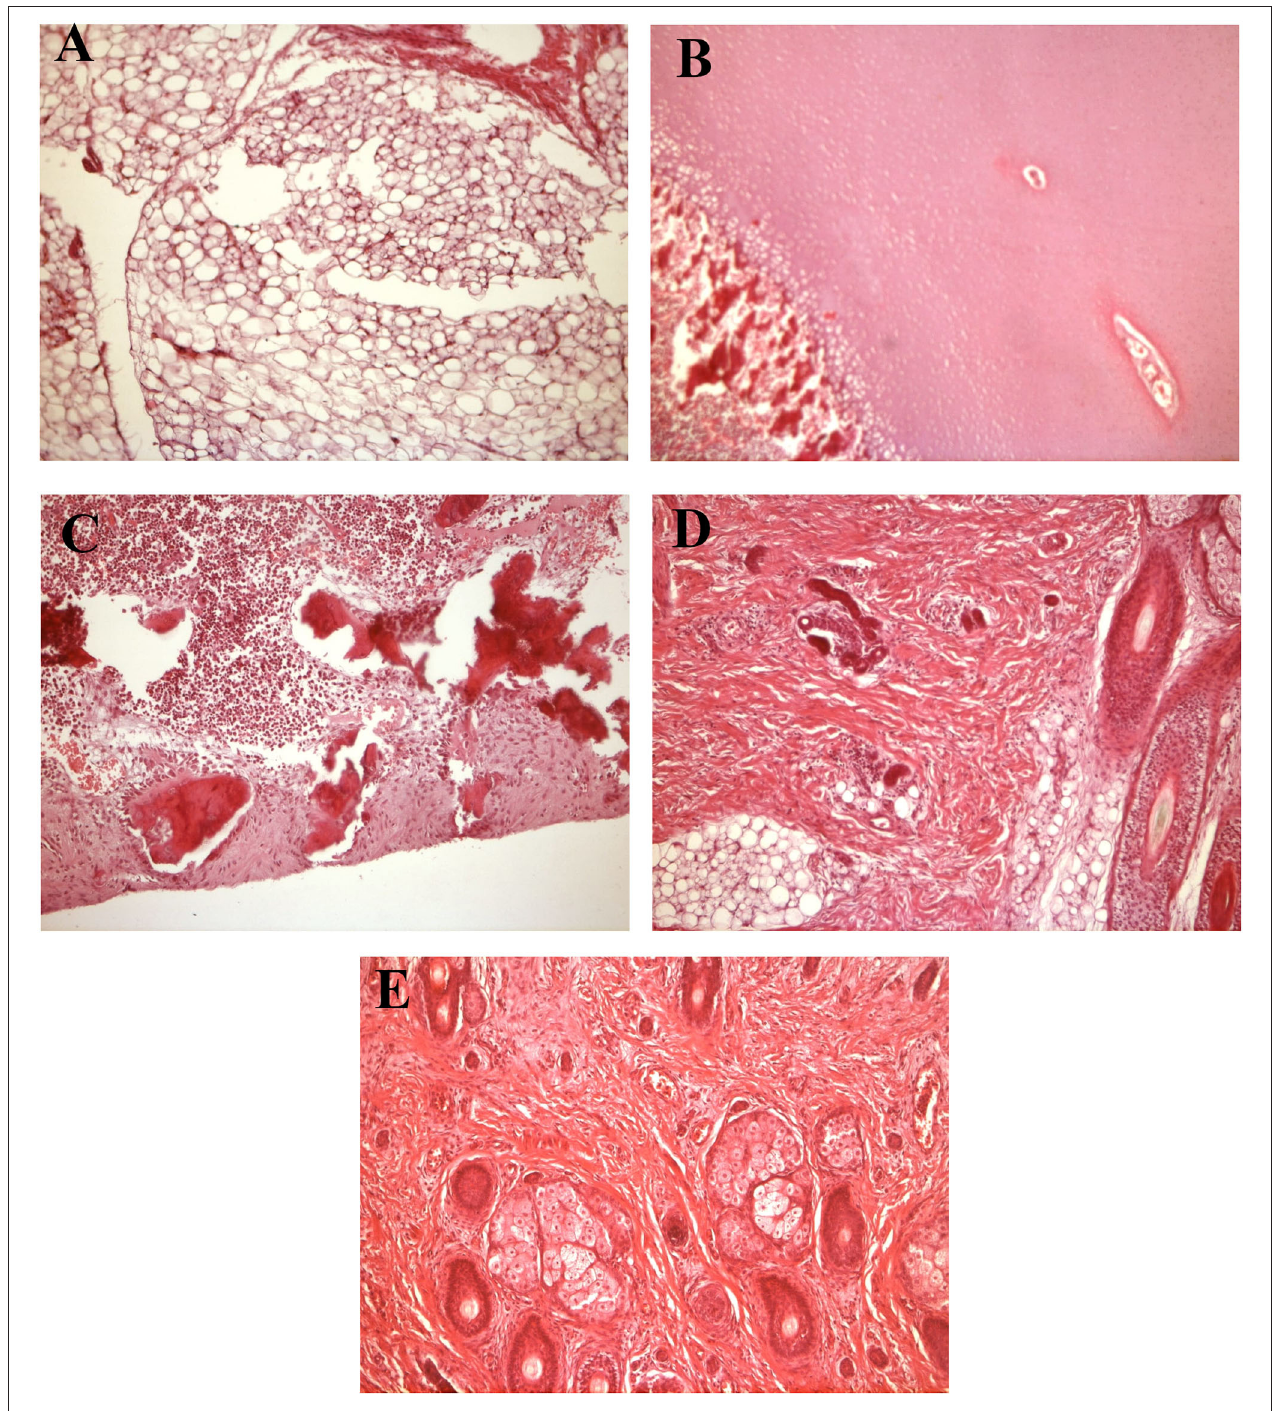
FIGURE 3 | Histology results. (A) Adipose tissue. (B) Cartilaginous tissue. (C) Bone marrow. (D) Hair follicles. (E) Single sebaceous